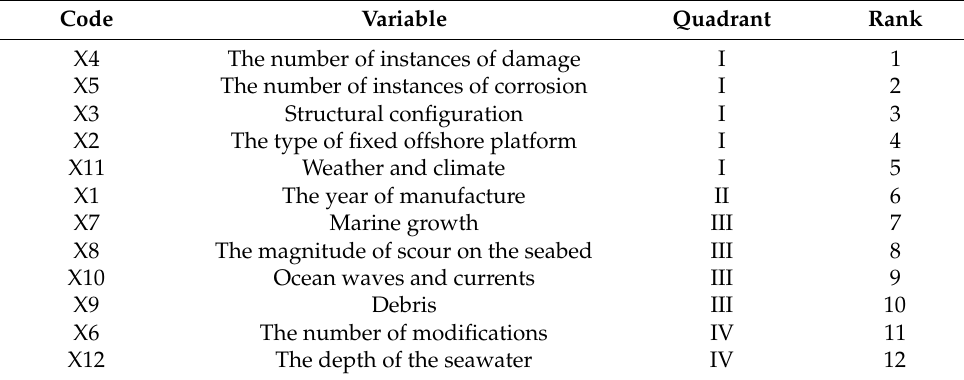
Figure 2. Scatter plot analysis of factors in inspections of fixed offshore platforms. Table 4. Most important